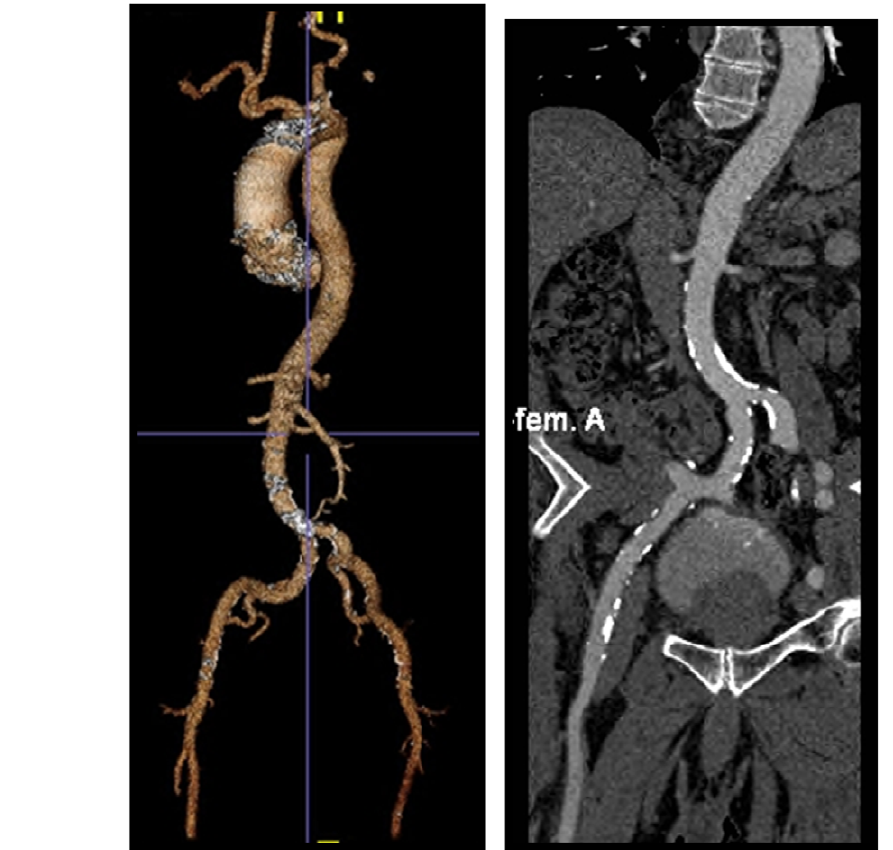
Figure 1. Contrast enhanced MDCT assessment of peripheral vasculature. Left: Volume-rendered image of the wholeaorta.Mildtortuositiesinbothiliofemoralarterieswithonlymildcalcification.Right:Curvedmulti-planar reformed image of the right femoral artery. Mild calcification with minimal size of 9 mm, which is favourable for transfemoral approach. contrast induced nephropathy and embolic phenomena [15] and the need for renal replacement therapy is increased. This needs to be considered by the multi-disciplinary team. In general, however, the risk post-TAVI is lower than after surgical